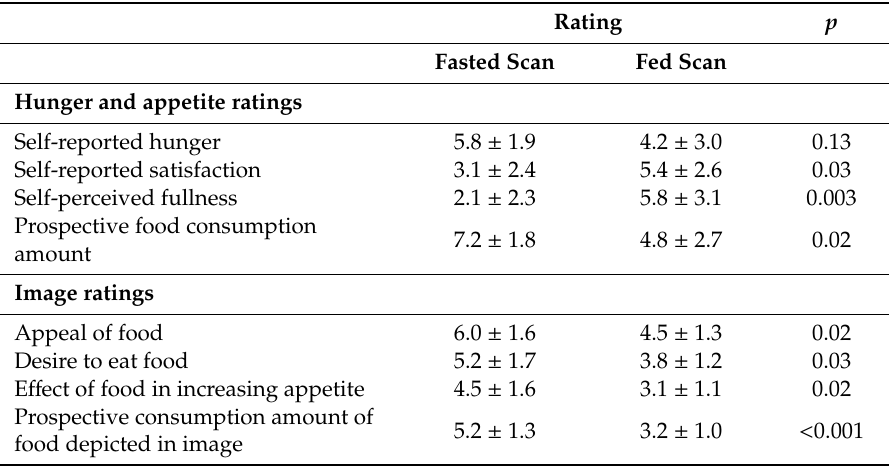
Table 2. Hunger, appetite and image ratings in the fasted and fed states.